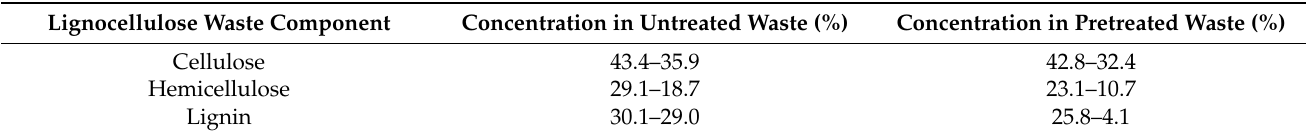
Table 2. Evidence of partial lignin-hemicellulose-cellulose lysis during lignocellulose waste pretreatment using alkaline pretreatments (Basis: 35 g of waste feedstock) [46].